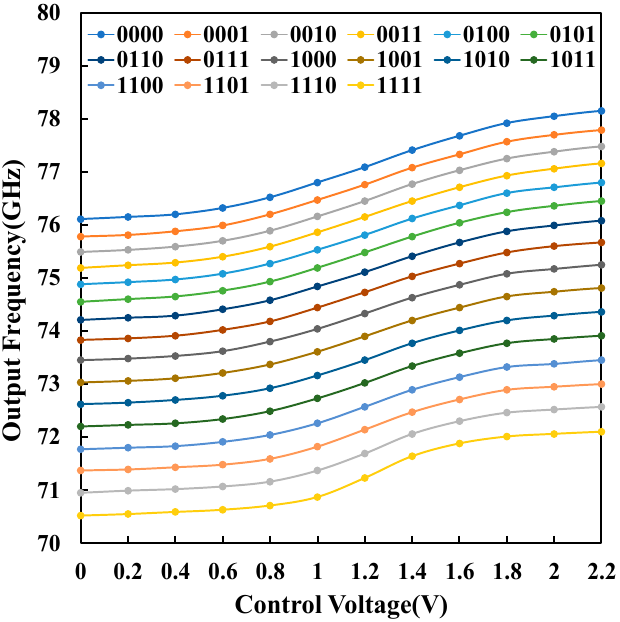
Figure 20. The tuning range of the on-chip VCO. Table 1. Performance comparison with other receiver designs.